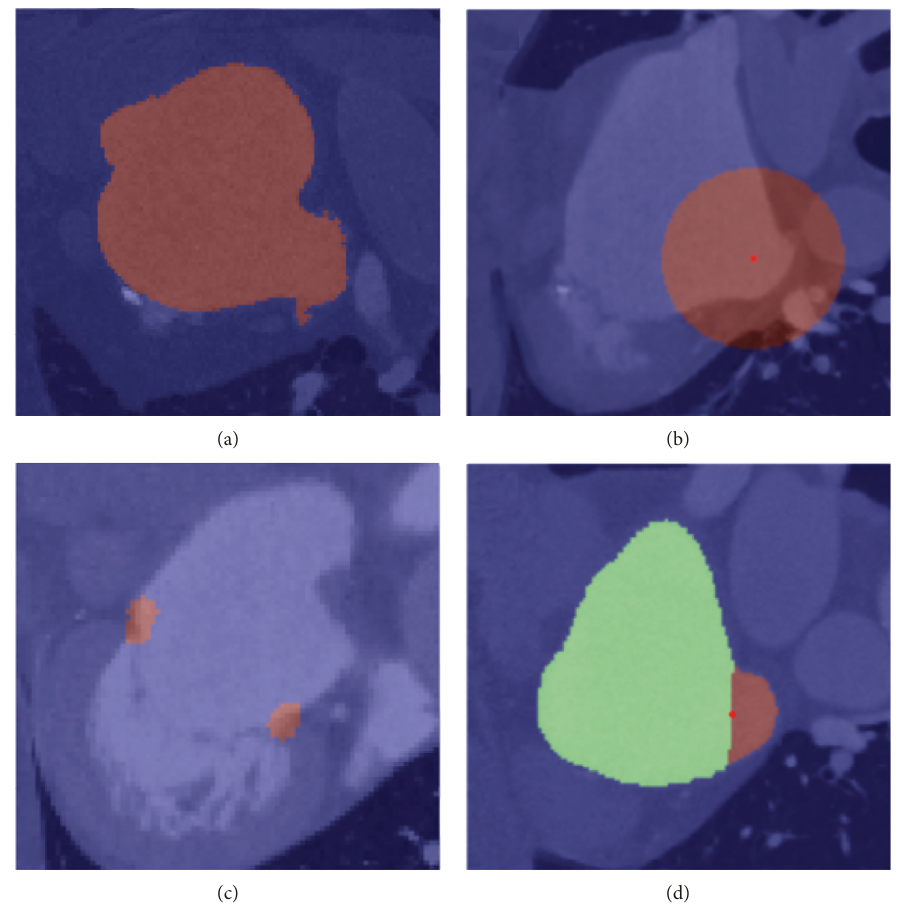
Figure 4: Different ground truth masks created for the AI model trainings, overlaid on top of the DICOM images. (a) Segmentation of the left atrium and left atrial appendage. (b) Point detection, where the dark red region (label) represents the spherical region around the point, and the bright red dot is the centroid of the mask identified as output. (c) 3D curve detection. (d) Plane detection, where the different labels are identified with different